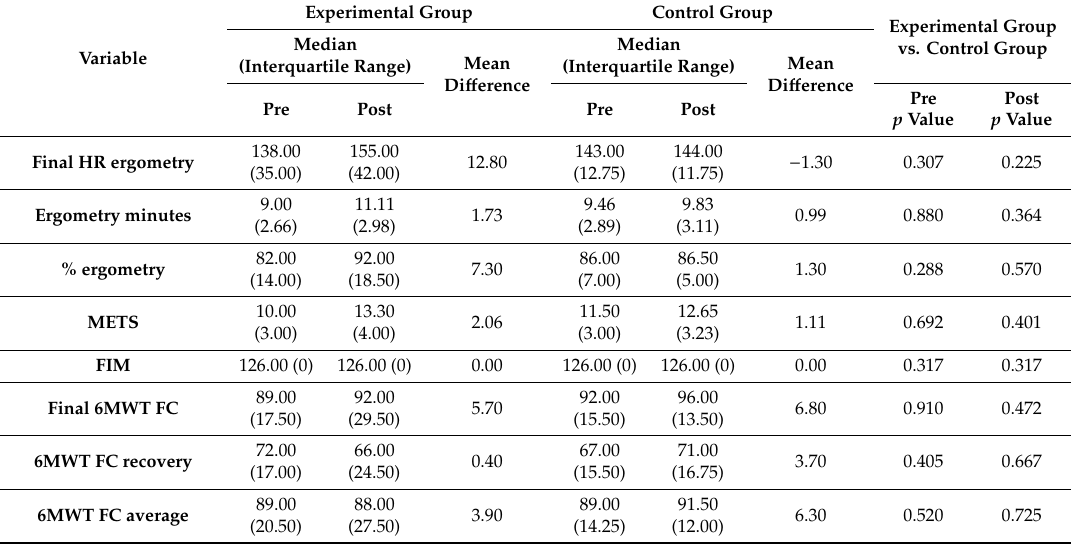
Table 4. Comparison of outcome measures between the experimental group and the control group (intergroup